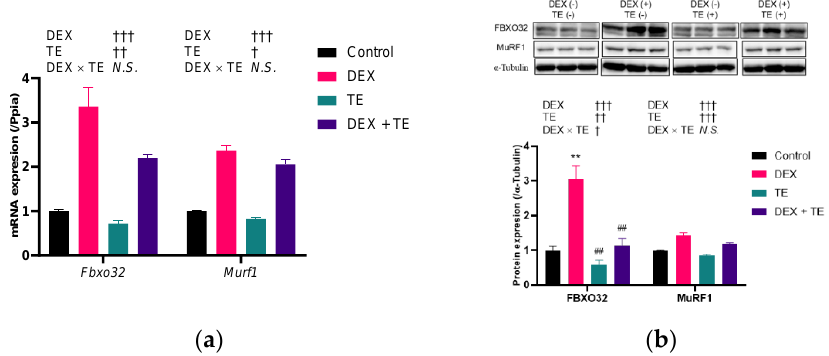
Figure 3. Effects of 200 µM of turmeric extract (TE) on gene and protein expression of atrophy-related factors in dexamethasone (DEX)-treated C2C12 myotubes. ( a ) Gene expression of Fbxo32 and Murf1. ( b ) Protein expression of FBXO32 and MuRF1. The results are shown as the mean ± standard error. PCR experiment: n = 4; Western blotting: n = 3. Statistical analysis was performed by two-way ANOVA, and where an interaction effect was detected, multiple comparison test was performed by Tukey – Kramer test. The results of two-way ANOVA and multiple comparison test are shown above and in the figure, respectively. † p < 0.05, †† p < 0.01, ††† p < 0.001 in two-way ANOVA, ** p < 0.01 vs. Control, ## p < 0.01 vs. DEX in multiple comparison test, N.S.: not